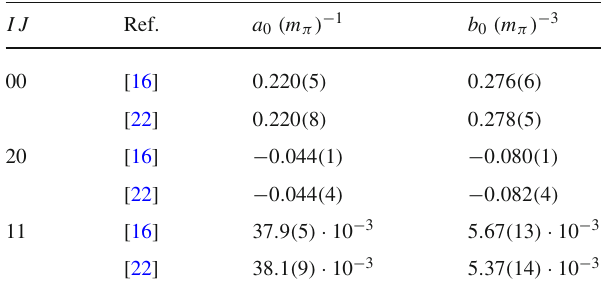
Table 4 f 0 ( 500 ) and ρ( 770 ) resonance poles obtained from the differ- ent fits without TPE with an increasing number of delta shells separated by (cid:14) r = 0 . 3 fm r c (fm)